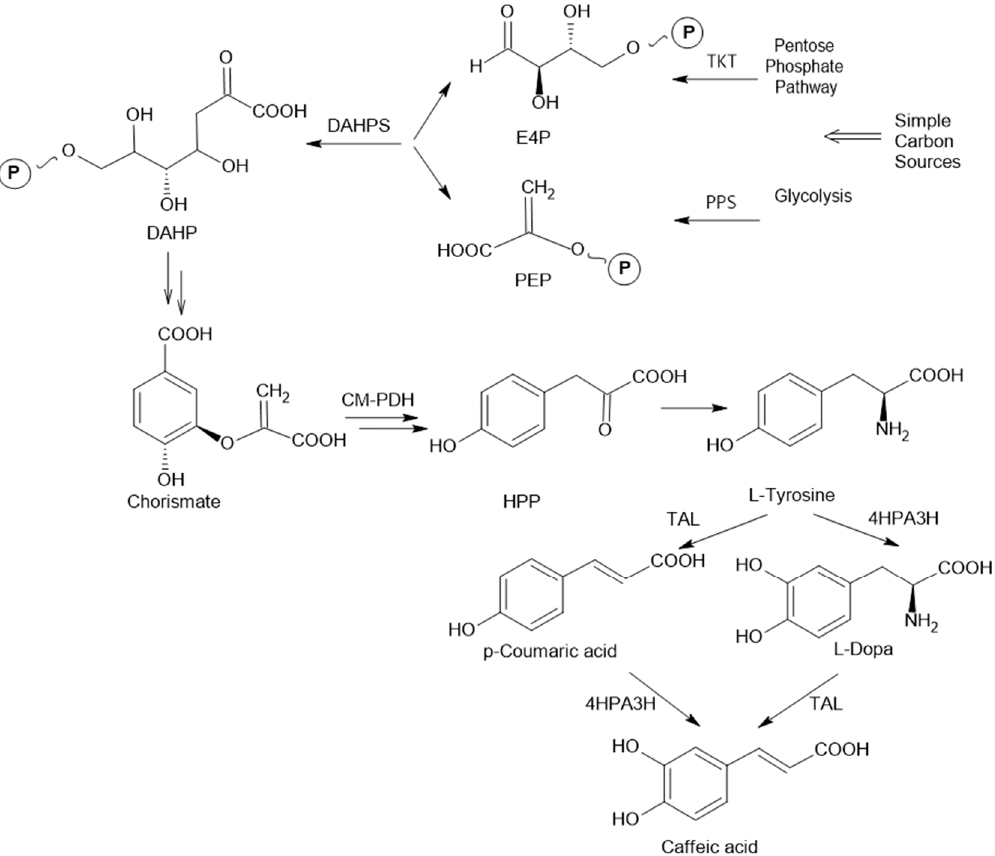
Figure 2. Proposed caffeic acid (CA) biosynthetic pathway. Native tyrosine biosynthetic pathway in E. coli and the artificial dual pathway mediated by 4HPA3H and TAL for CA biosynthesis from tyrosine. PPS: phosphoenolpyruvate synthase; TKT: transketolase; CM-PDH: chorismate mutase-prephenate dehydrogenase; DAHPS: 3-deoxy-D-arabino- heptulosonate-7-phosphate synthase; 4HPA3H: 4-hydroxyphenylacetate 3-hydroxylase; TAL: tyrosine ammonia lyase; E4P: D-erythrose-4-